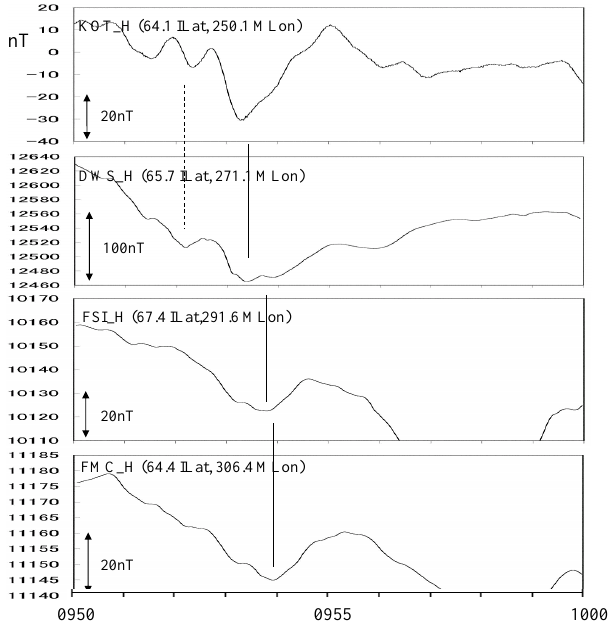
Figure 11. Same as Fig. 10 but for auroral zone stations of KOT, DWS, FSI, and FMC. Dotted and solid lines mark the peaks of the negative amplitudes of DWS at 09:52:10 and 09:53:20UT, respec- tively. Peak of the negative pulse at FSI and FMC was at 09:53:45 and 09:53:50UT, respectively. Time resolution of KOT was 1s, while resolutions were 5s for DWS, FSI, and FMC.